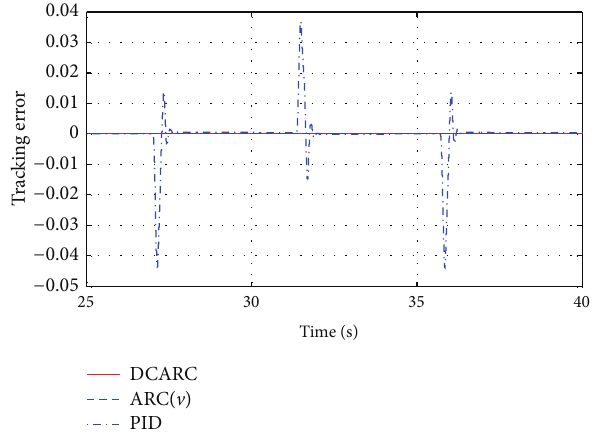
Figure 9: Tracking errors in point to point motion in the presence of parametric uncertainty only.